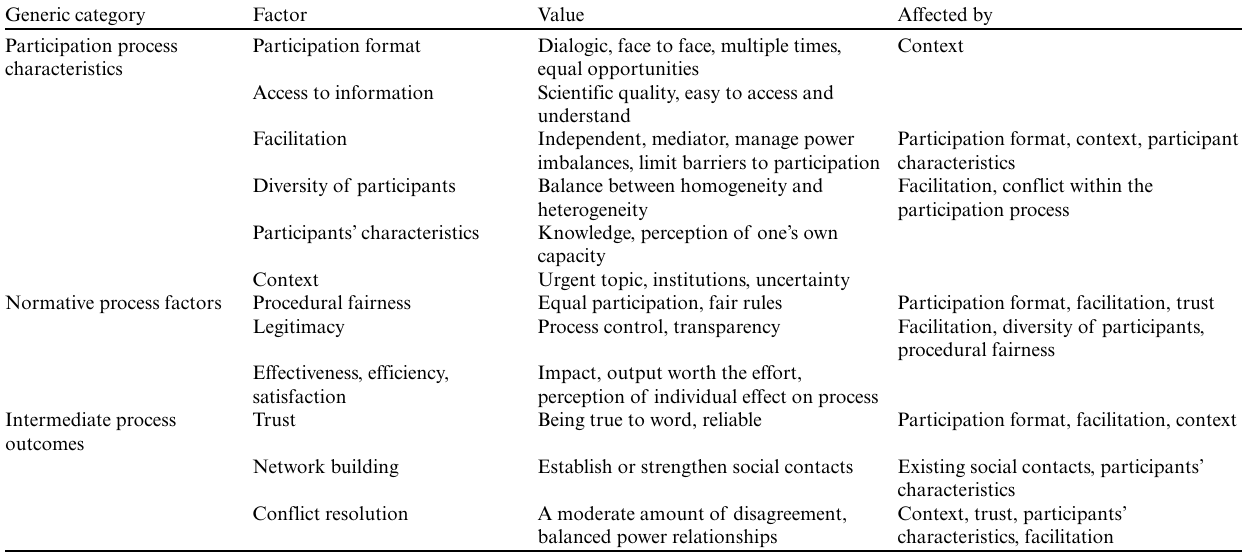
Table 1. Factors influencing social learning.